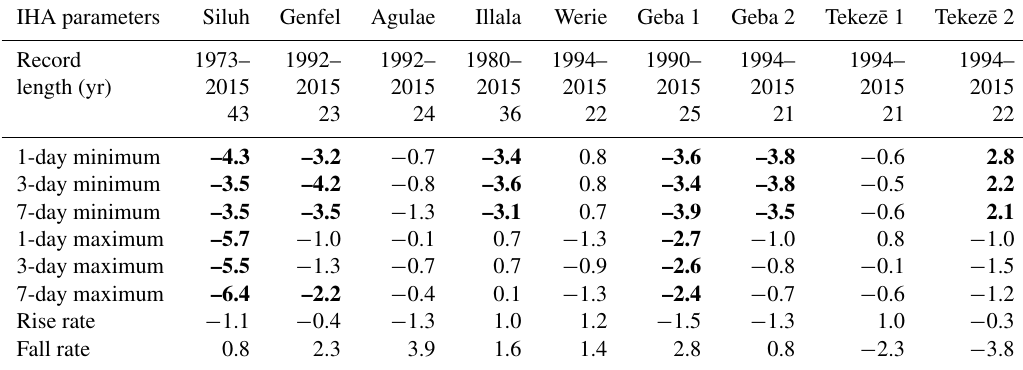
Table 6. Summary results of MK and Z statistics on IHA trends. Negative (positive) Z value indicates a decreasing (increasing) trend and statistically significant trends at 5% confidence level are shown in bold ( Z =±